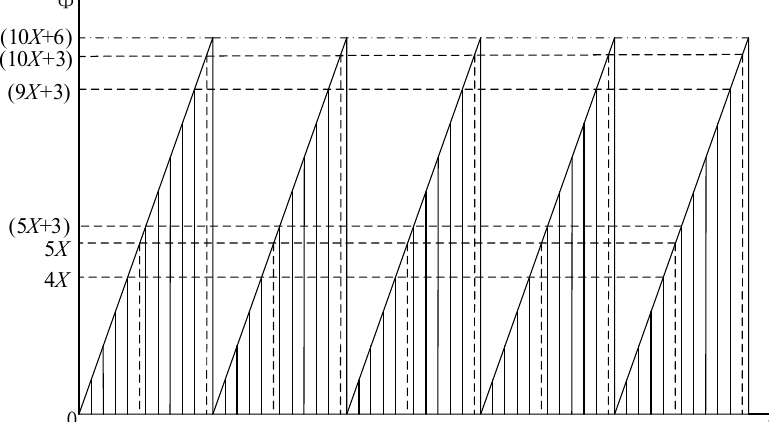
Figure 4. Address sampling method of the new DDS method. Address sampling model of the new DDS method for outputting 10 MHz signal in 100 MHz reference clock.